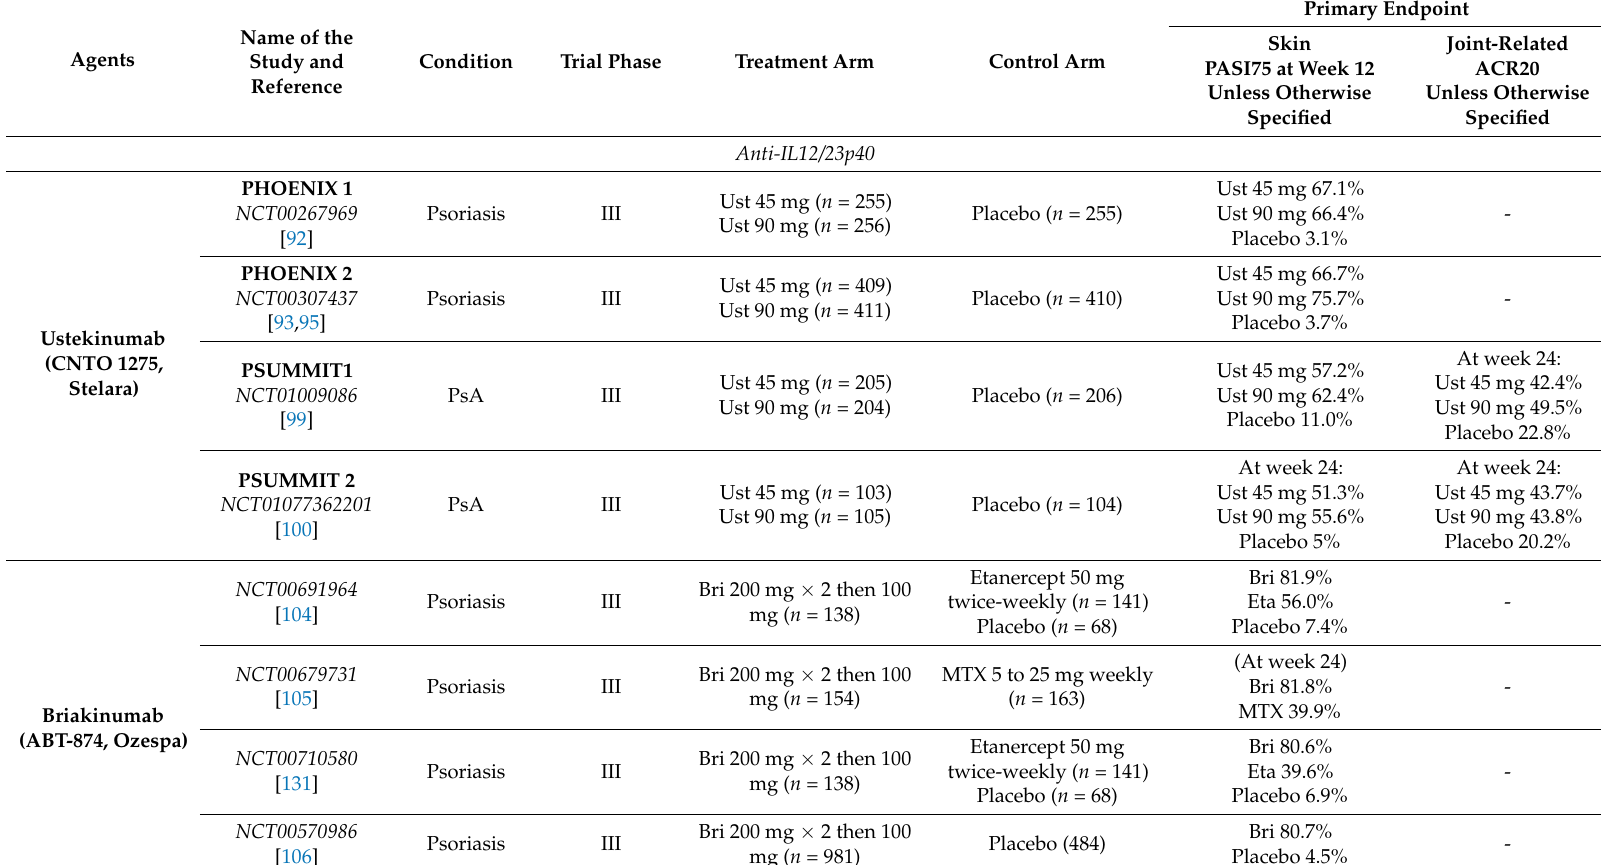
Table 1. Randomized clinical trials on inhibitors of the IL-23/IL-17 axis in Psoriasis and Psoriatic Arthritis. Ust: Ustekinumab; Bri: Briakinumab; MTX: Methotrexate; Gus: Guselkumab; Ada: Adalimumab; Ris: Risankizumab; Til: Tildrakizumab; Eta: Etanercept; Sec: Secukinumab; Ixe: Ixekizumab; Bro: Brodalumab; PASI: Psoriasis Area and Severity Index; ACR: American College of Rheumatology; IGA: Investigator’s Global